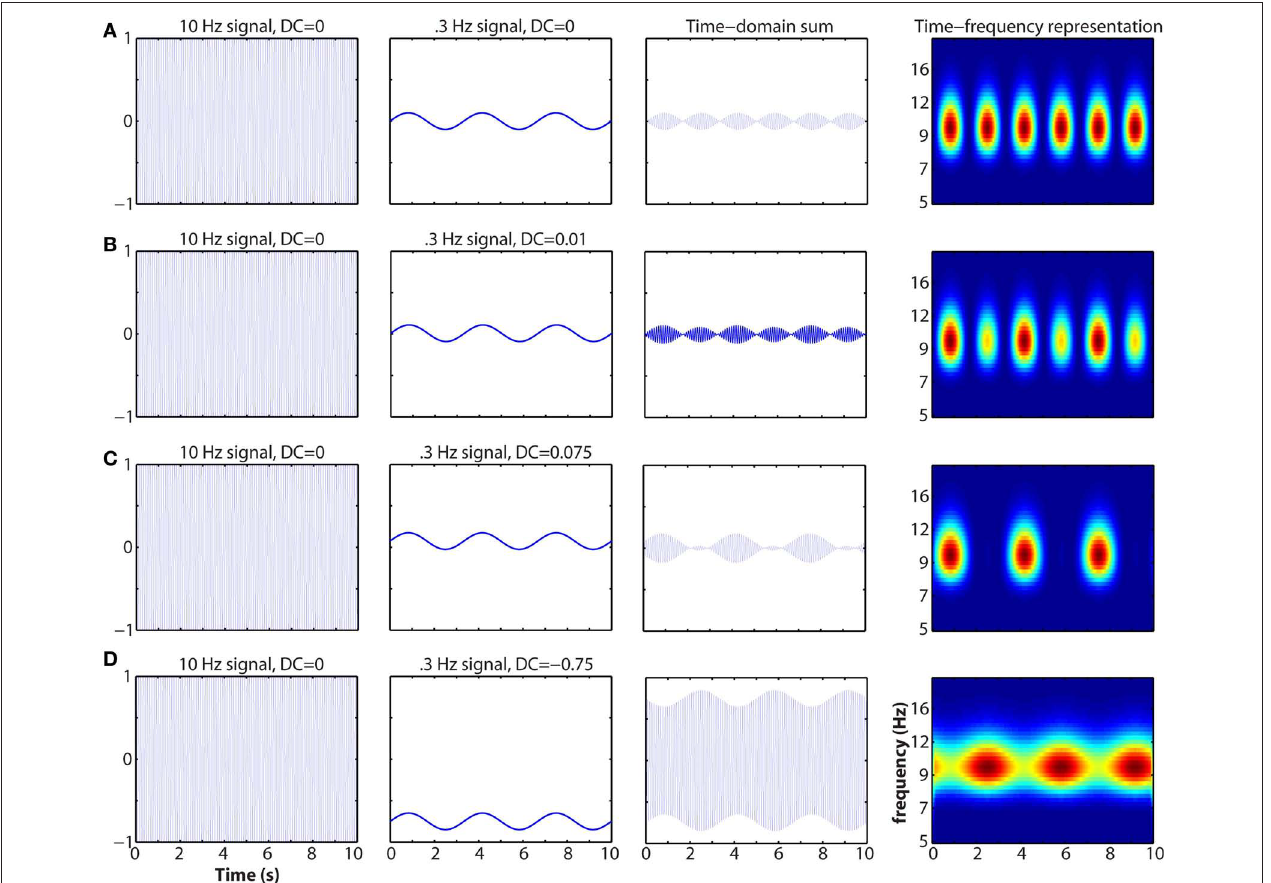
Oscillation baseline shifts and amplitude asymmetries have been described before and linked to cognitively relevant event-related potentials (Nikulin et al., 2007; Mazaheri and Jensen, 2008). This simulation demonstrates that the sensitivity of M/EEG measurements is not infallible, although they may still provide deeper insights into neurocognitive function compared to functional